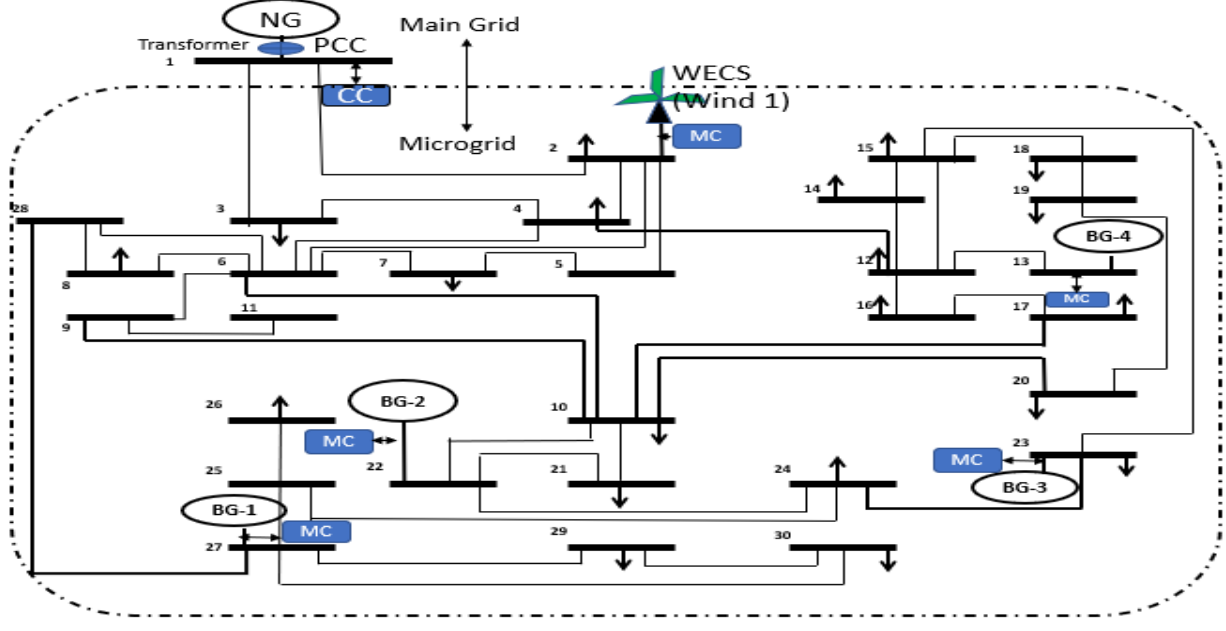
Figure 10. Modified IEEE 30 Bus system with a grid-connected microgrid. The typical load profile is shown in Figure